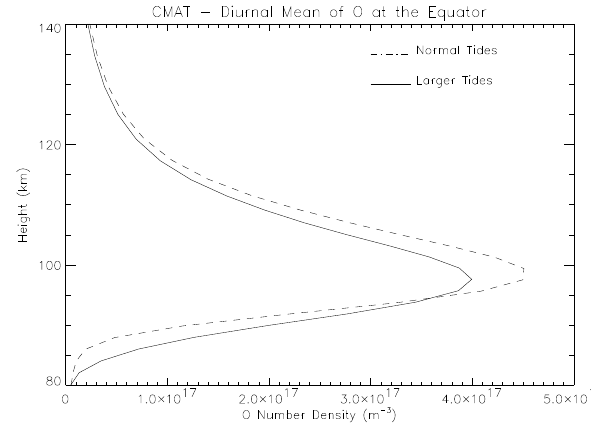
Fig. 8. Diurnal mean of atomic oxygen at the equator as calcu- lated by CMAT with normal (dashed) and × 2 . 5 lower boundary tidal forcing